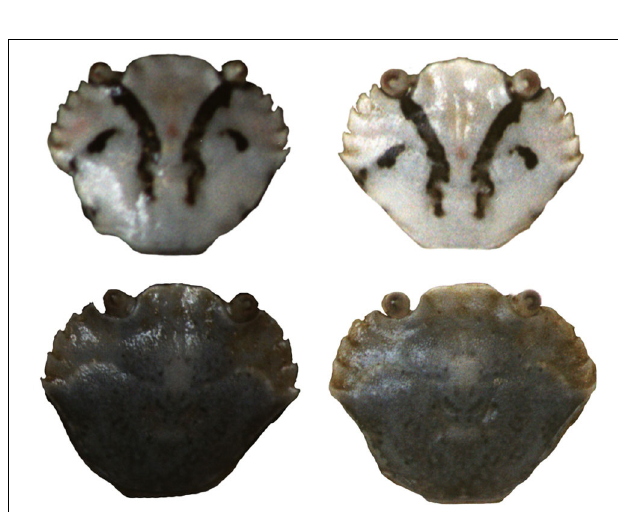
but there was no difference in hue 1 or hue 2. Hue 1 and 2 yield values based on a ratio of color channel or cone catch values (see main text), saturation is between 0 and 0.75, and brightness is reflectance between 0 and 1.